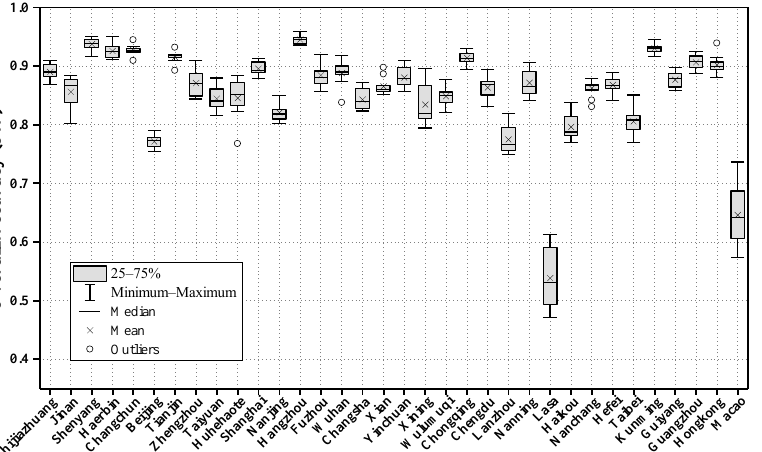
Figure 5. The box plot of overall accuracy in all selected cities. (Note: X -axis shows the 34 Chinese cities; Y -axis shows the overall accuracy ranging from 0–1; a legend is given at the lower-left corner.)